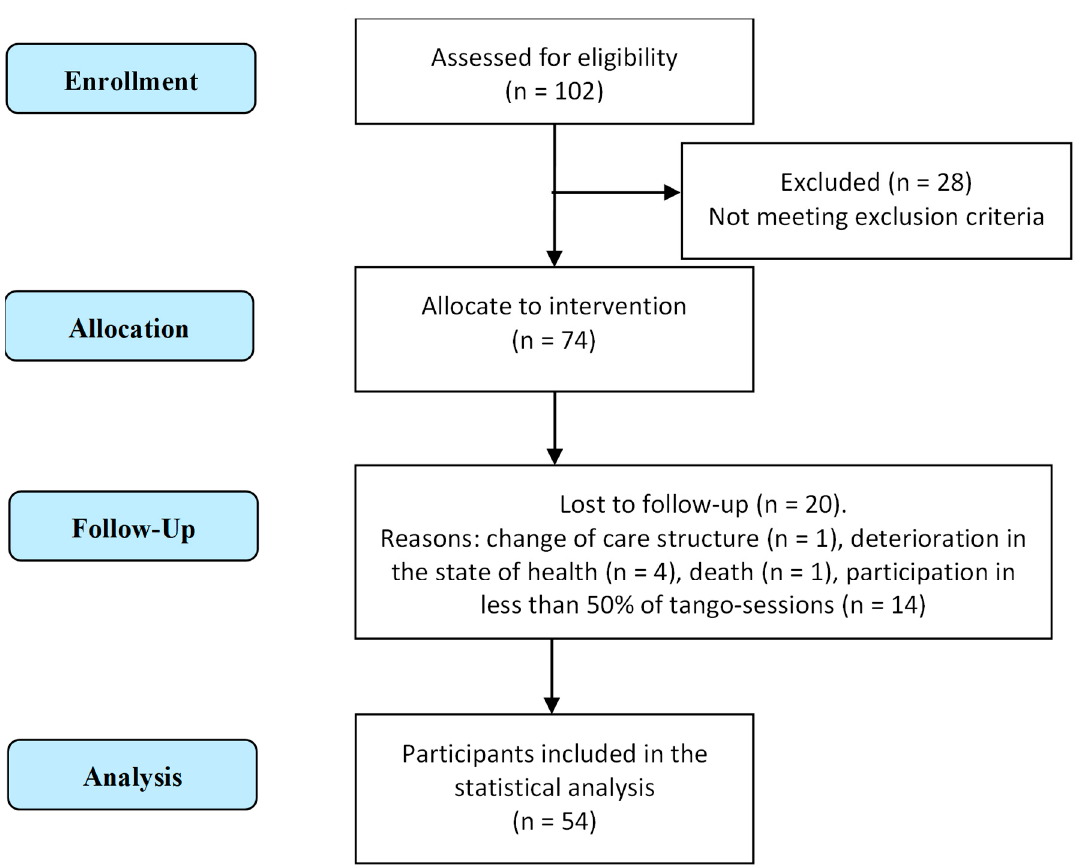
Figure 1. Flowchart for enrollment, allocation and follow-up of participants. Table 3. Participant characteristics.